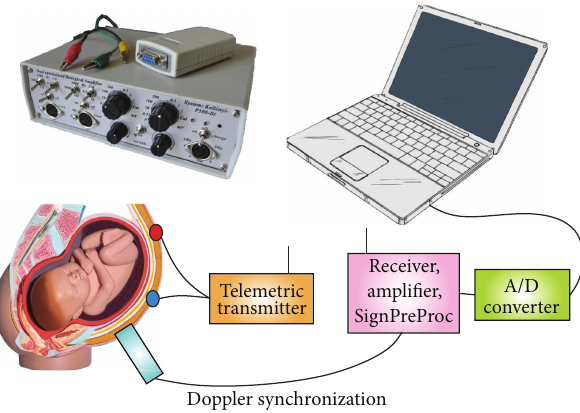
Figure 1: Schematic representation of the developed system. Stan- dard Ag-AgCl electrodes are placed on the mother’s abdomen. Preamplified signals are sent telemetrically to the receiver, where the first steps of signal processing happen. The collected data are transmitted through an A/D converter to the computer. Doppler signals are used to synchronize the fetal heart